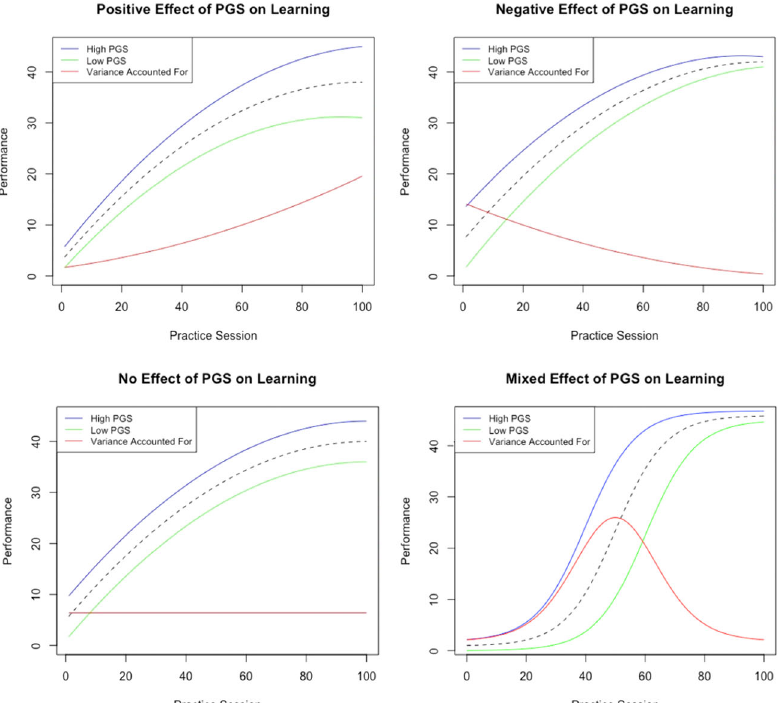
Fig. 1 Conceptualization of the genetic effects on rates of learning. Top left fi gure is an example of magni fi cation of genetic effects on initial levels of performance across time, where there are differences in the slope of learning between high and low PGS groups and the differences translate to more variance accounted for by genes. Top right fi gure is an example of a negative association between PGS and rates of change, where the genetic effects on initial levels of performance decrease over time and the experience equalizes differences between the two groups. Bottom left fi gure is an example that shows no association between the PGS and rates of change, indicating that the genetic effects remain constant across the environmental range and there is no genetic effect of PGS on learning. Lastly, bottom right fi gure is an example that shows a combination of all three